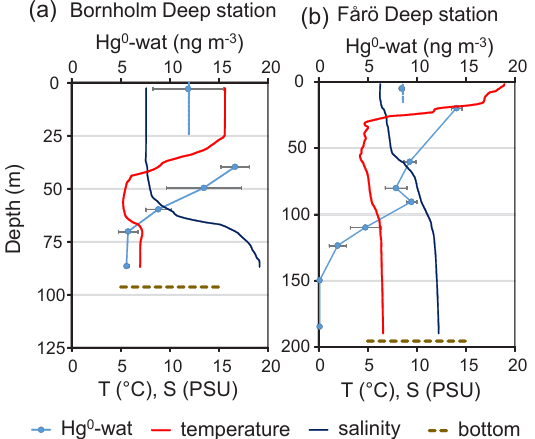
Figure 5. The vertical profiles of Hg 0 , temperature ( T ), and salinity ( S ) at the (a) Bornholm Deep and (b) Fårö Deep stations.